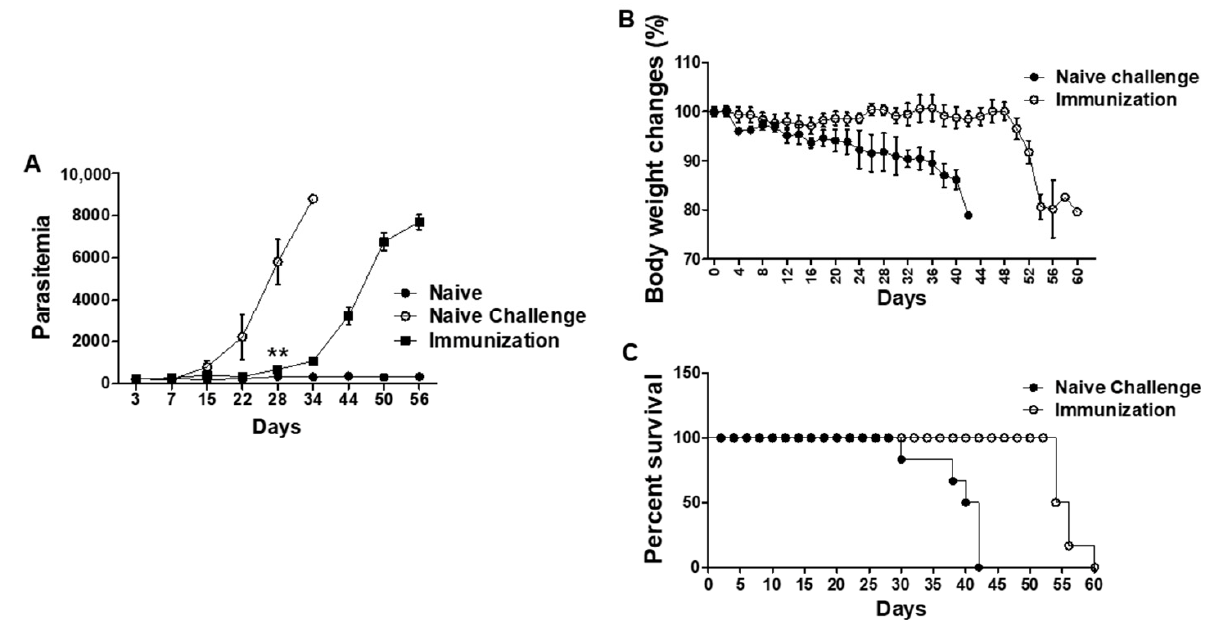
Figure 6. Parasitemia and survival. RBCs of P. berghei challenge-infected mice were collected for parasite enumeration via flow cytometry ( A ), ** P < 0.01. Body weight changes and survival rates of mice were determined at two days interval after P. berghei infection ( B , C ). The error bars represent SEM.